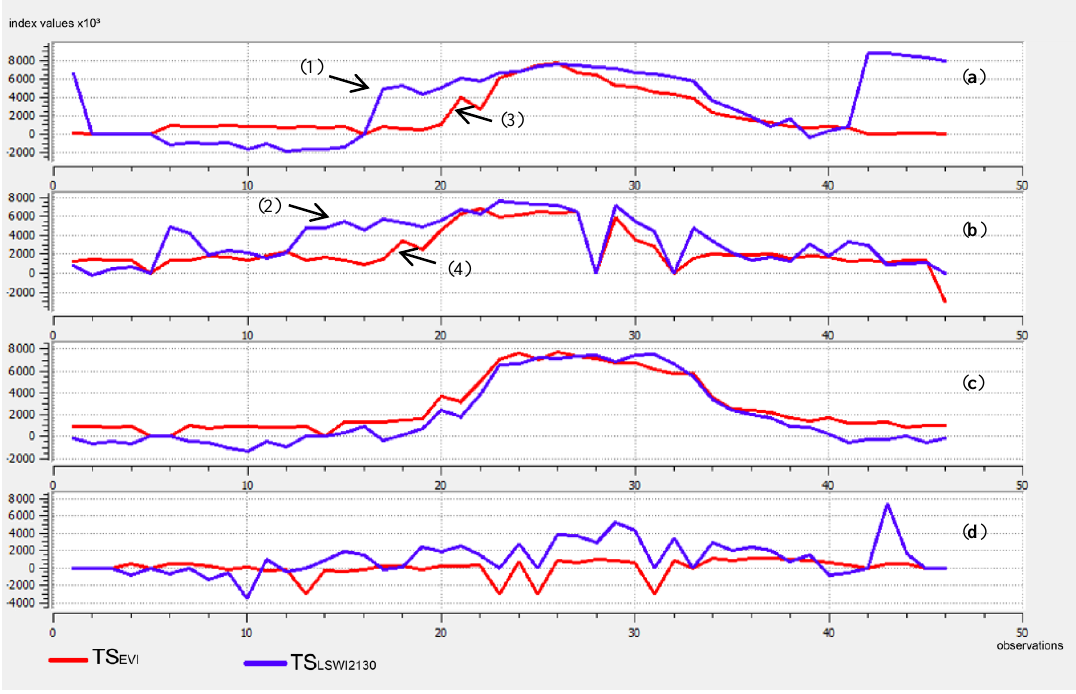
Figure 3. Temporal profile of TS EVI and TS LSWI2130 of two rice paddies (( a ) Lake Xingkai, Heilongjiang province; ( b ) Lu’an, Anhui province), a corn field (( c ) Bohai Bay, Tianin province) and aquaculture ponds (( d ) Dongting Lake, Hunan province).